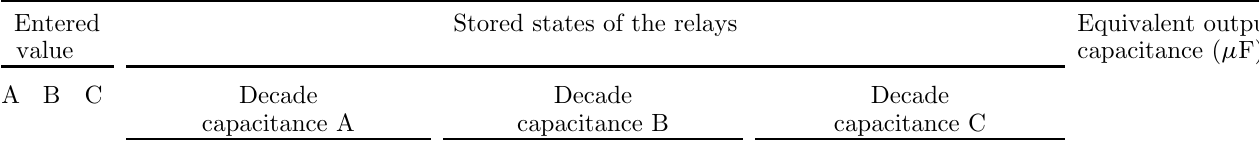
Table 1. Combinations of the four capacitive elements of each decade to generate the required equivalent capacitance values with the corresponding relays states (S), where S = 1 (closed), S = 0 (open) and A, B, C are the entered required capacitance values for each decade respectively.